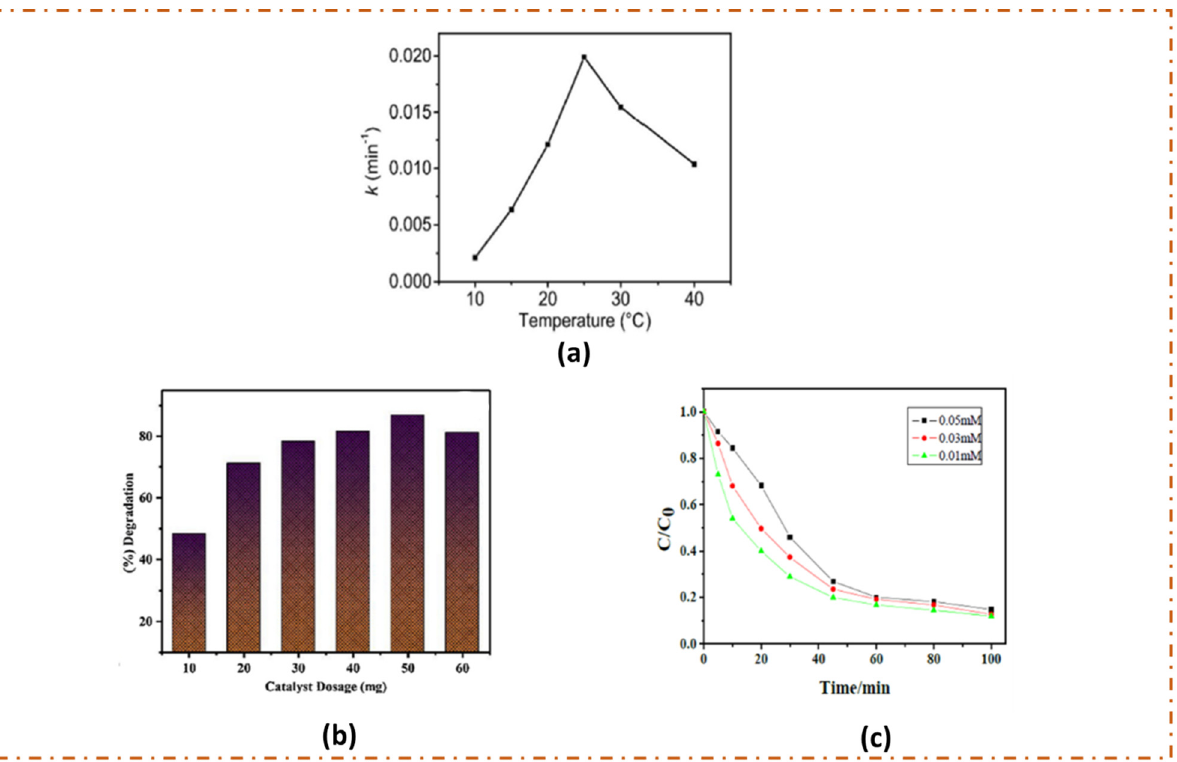
Figure 6. ( a ) Effect of temperature on MB degradation rate “Reprinted/adapted with permission from Ref. [53]. 2018, ACS”. ( b ) Effect of ZnFe 2 O 4 /rGO catalyst dosage on MB degradation “Reprinted/adapted with permission from Ref. [84]. 2021, Elsevier” ( c ) effect of initial AO7 concentra- tion on its degradation over CuFe 2 O 4 /GO surface “Reprinted/adapted with permission from Ref. [60]. 2016, Elsevier”.